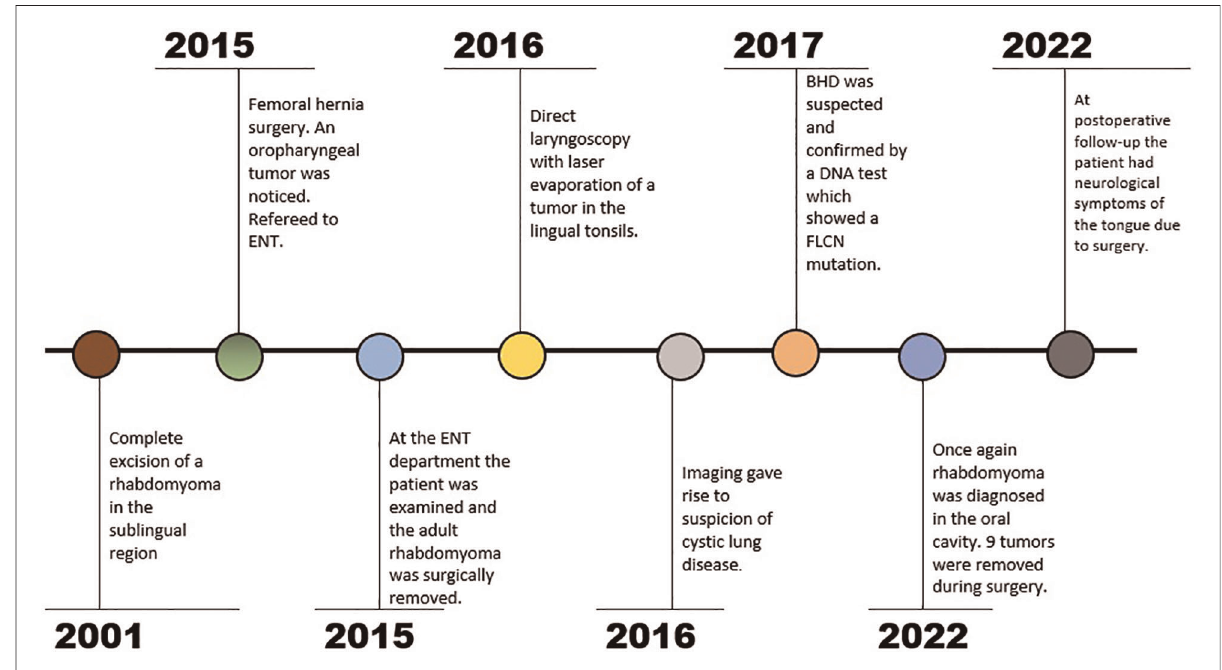
FIGURE 1 Text description: